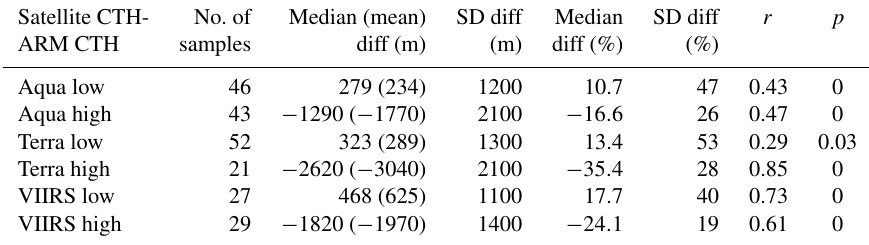
Table 3. Median and mean differences, standard deviations of the differences, correlation coefficients and p values between satellite and ARM cloud top heights (CTH) for nighttime low and high cloud separately.